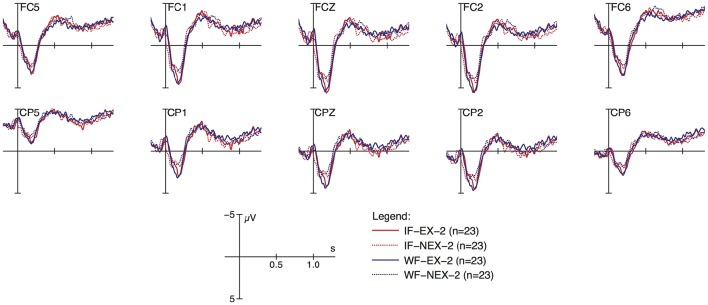
ERP responses to stimuli at anterior (top) and posterior (bottom) electrodes; data from response-elicitation phase, session 2.